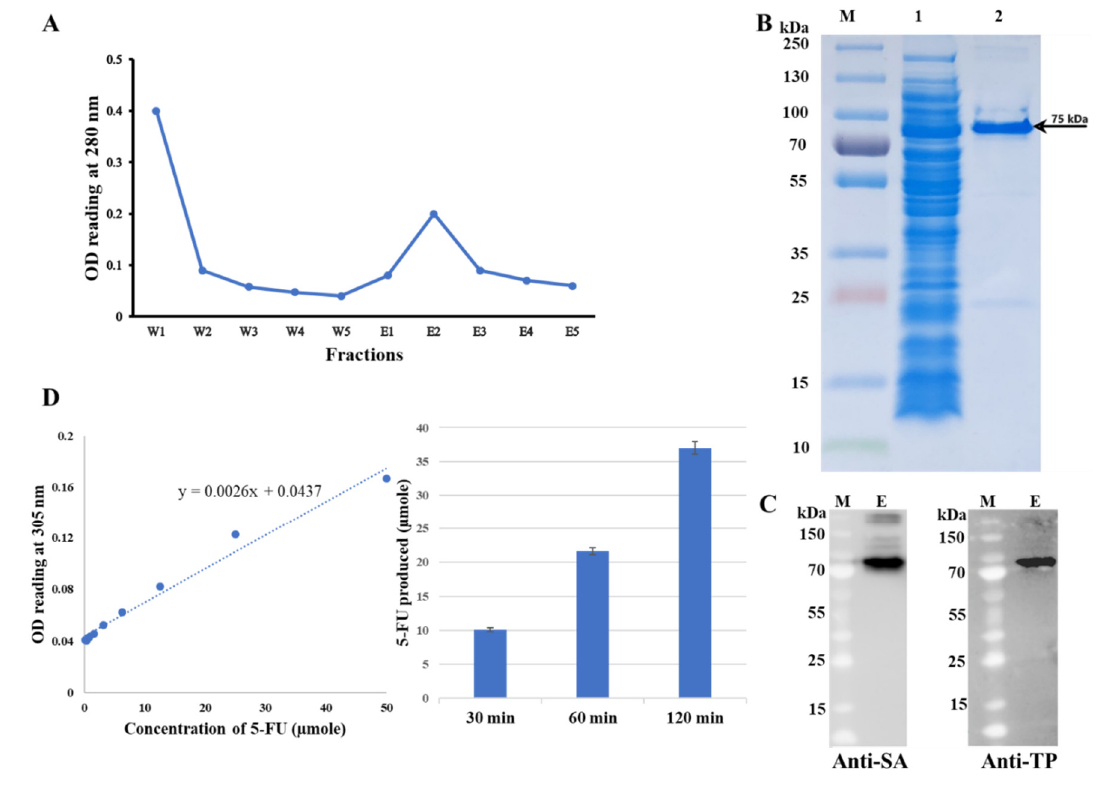
Figure 4. ( A ) Elution profile of TP-coreSA fusion protein using five washes and five elutions; ( B ) SDS-PAGE imaged as (M) protein ladder, (1) crude bacterial lysate, (2) purified TP-coreSA fusion protein; ( C ) Western blot against anti-TP and anti-SA, (M) is protein ladder, (E) is purified TP-coreSA; ( D ) Measurement of enzyme activity of TP-coreSA fusion protein using a microplate reader. The change in absorbance at 305 nm is used to calculate the 5-FU released after incubation of TP-coreSA in the presence of 5 (cid:48) -DFUR for up to 2 h with the help of 5-FU calibration curve.